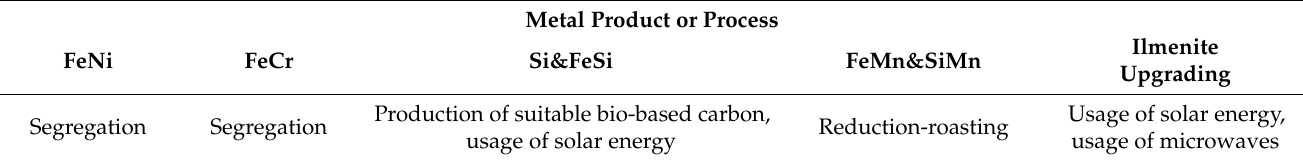
Table 8. Novel processes and special emphasis investigated for the production of metals and ilmenite upgrading.